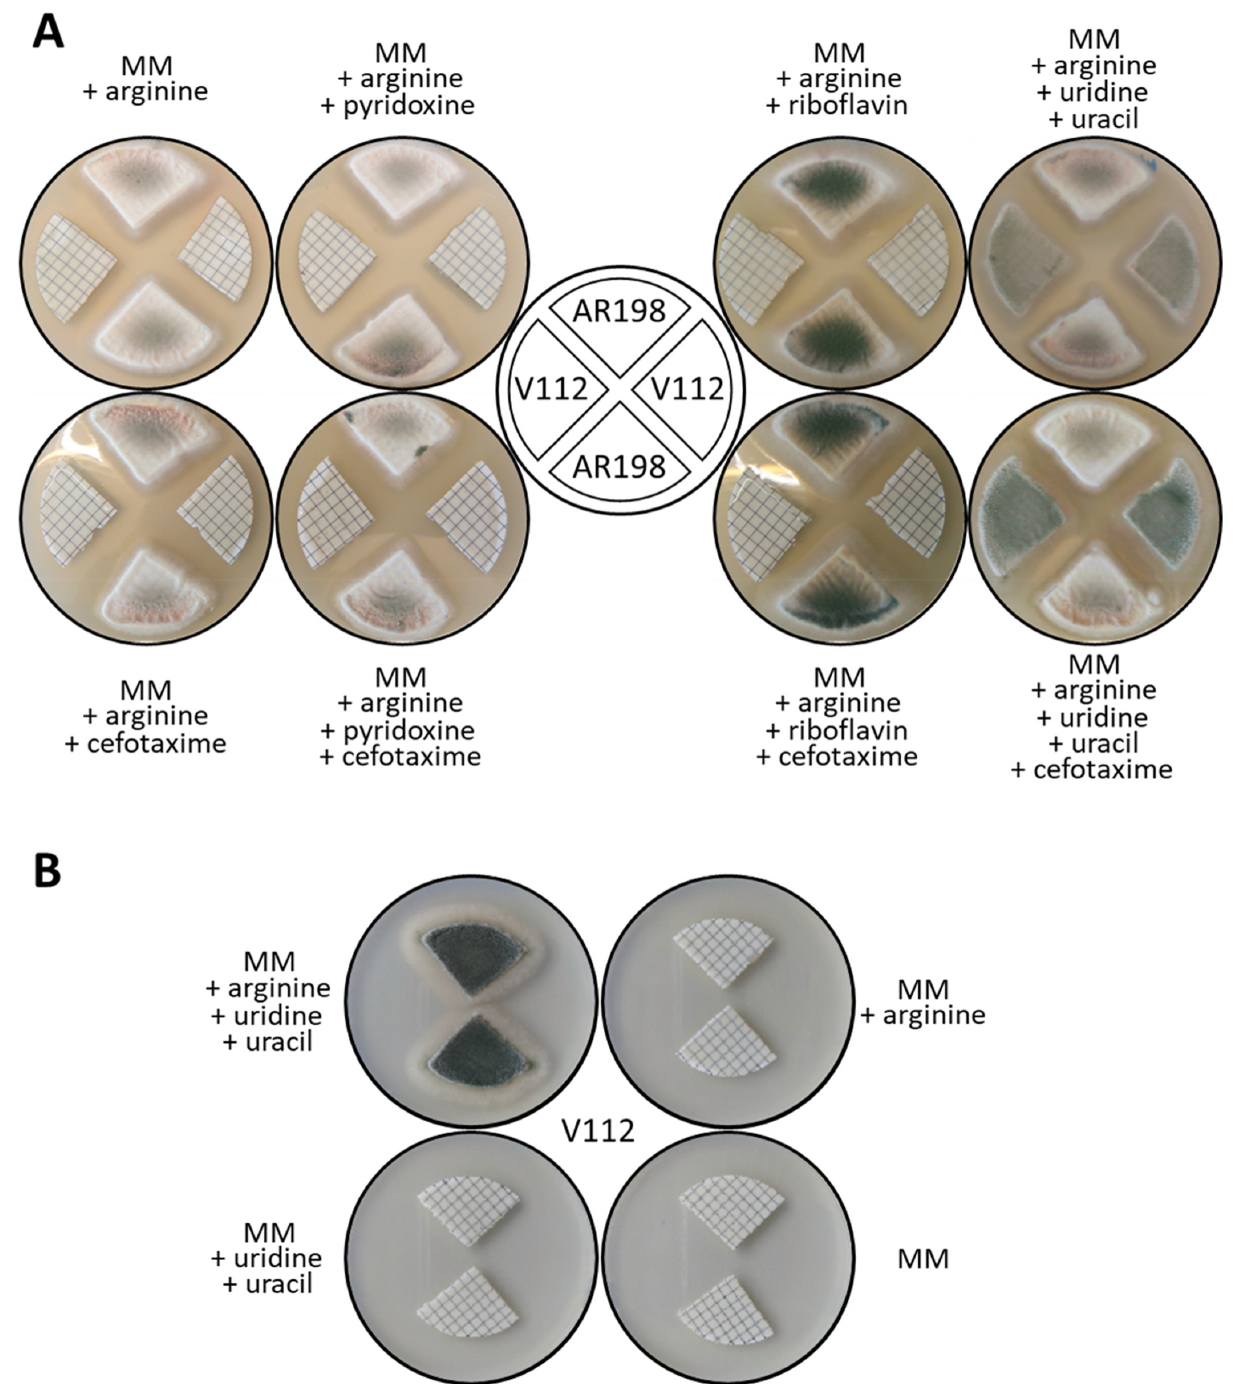
Figure 5. Nutrient cross-feeding. ( A ) Suppression of riboflavin and pyridoxine auxotrophies by A. tumefaciens . Relevant genotypes: AR198 ( riboB2 , pyroA4 ) and V112 ( pyrG89 , argB2 ). ( B ) Arginine auxotrophy in V112 is not suppressed by A. tumefaciens .